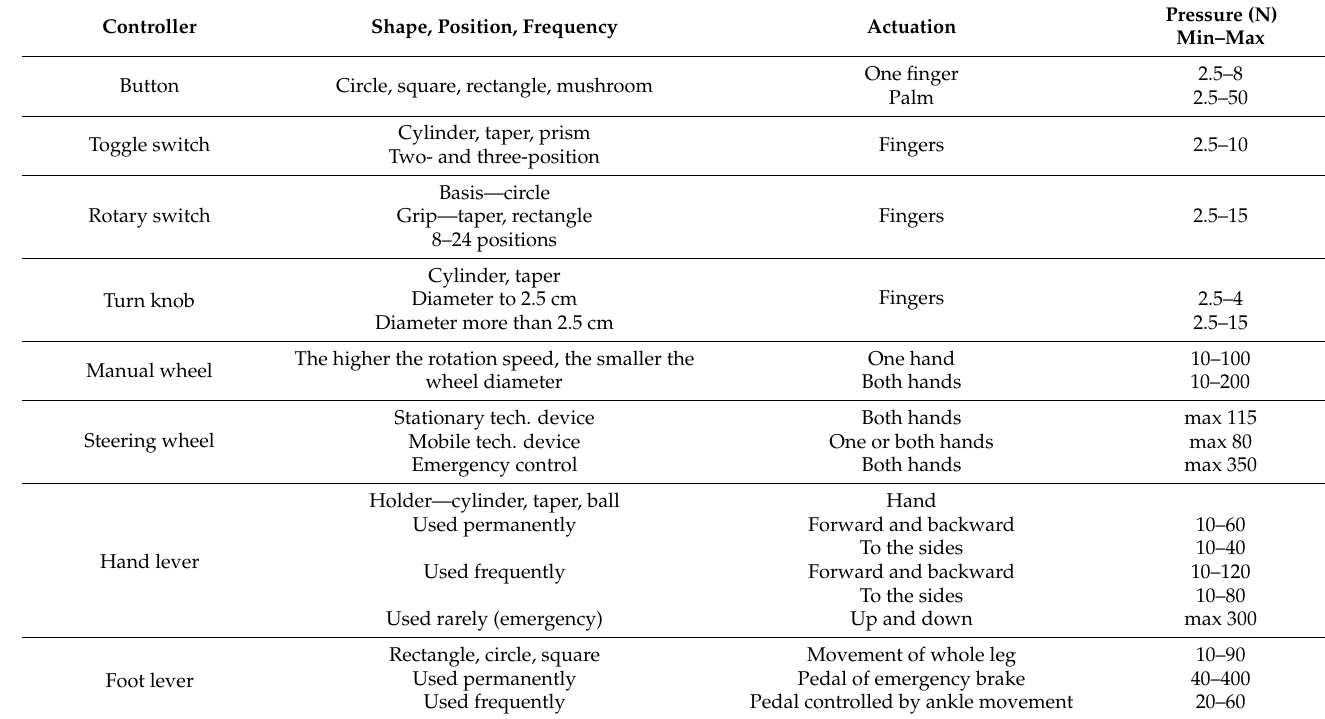
Table 1. Controllers [9].